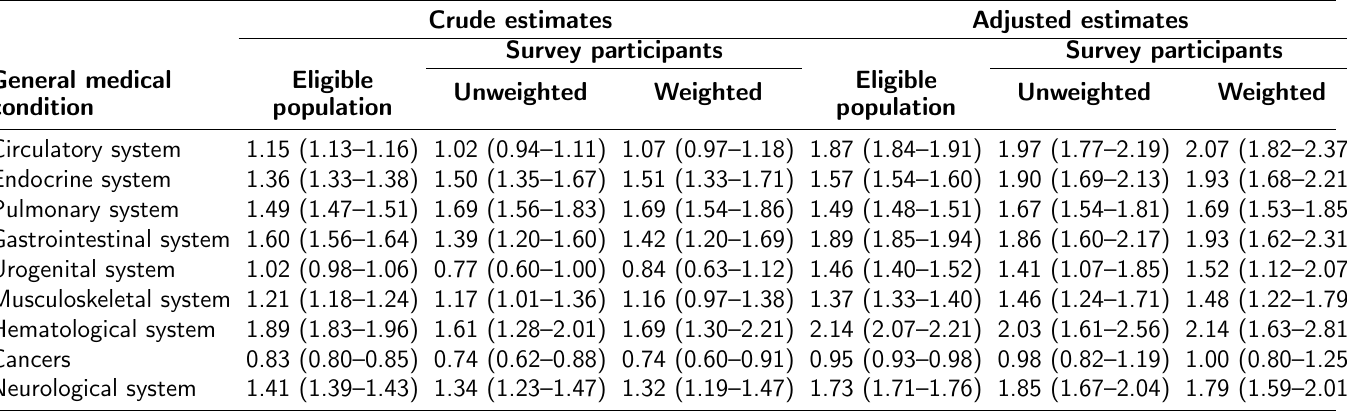
Supplementary Table 7: Odds ratios and 95% confidence intervals for associations between any mental disorder and nine general medical conditions, among all those eligible for the 2017 Central Denmark Region and the How are you? survey participants (unweighted and weighted). Adjusted models were adjusted for sex, age group, and